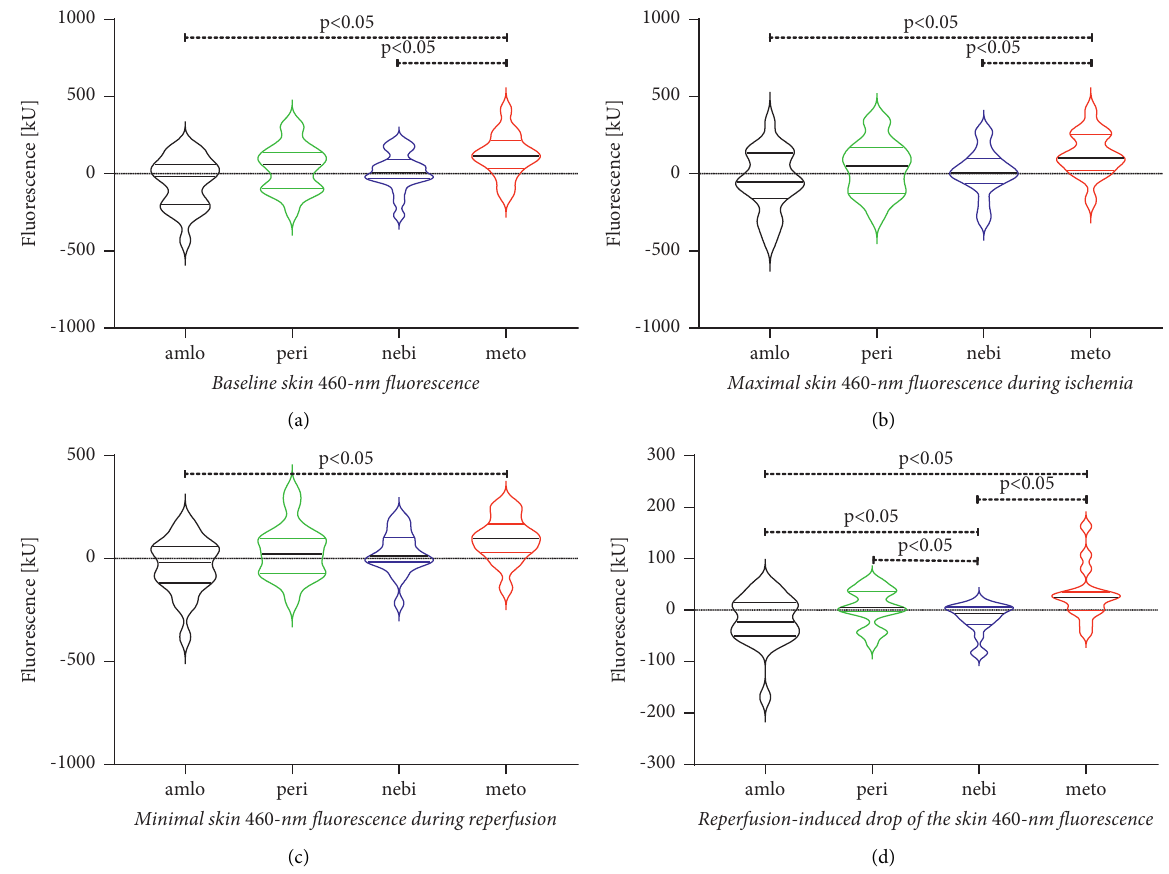
Figure 3: Violin plots with median (black bold lines) and values of the interquartile ranges (thin lines in the colours of the respective violin shapes) for the FMSF parameters, which differed significantly between visit 1 and visit 2. Results for patients randomised to once a day 5mg of amlodipine are shown as black violins, to 5 mg of perindopril as green violins, to 5mg of nebivolol as blue violins, and to twice a day 50mg of metoprolol as red violins. In panel S, the between-visits’ differences in the Bmean are presented, in panel B in the FImax, in panel C in the FRmin, and in panel D in the Rmin. For explanations of the FMSF parameters, refer to the main text in the methodology section and Figure